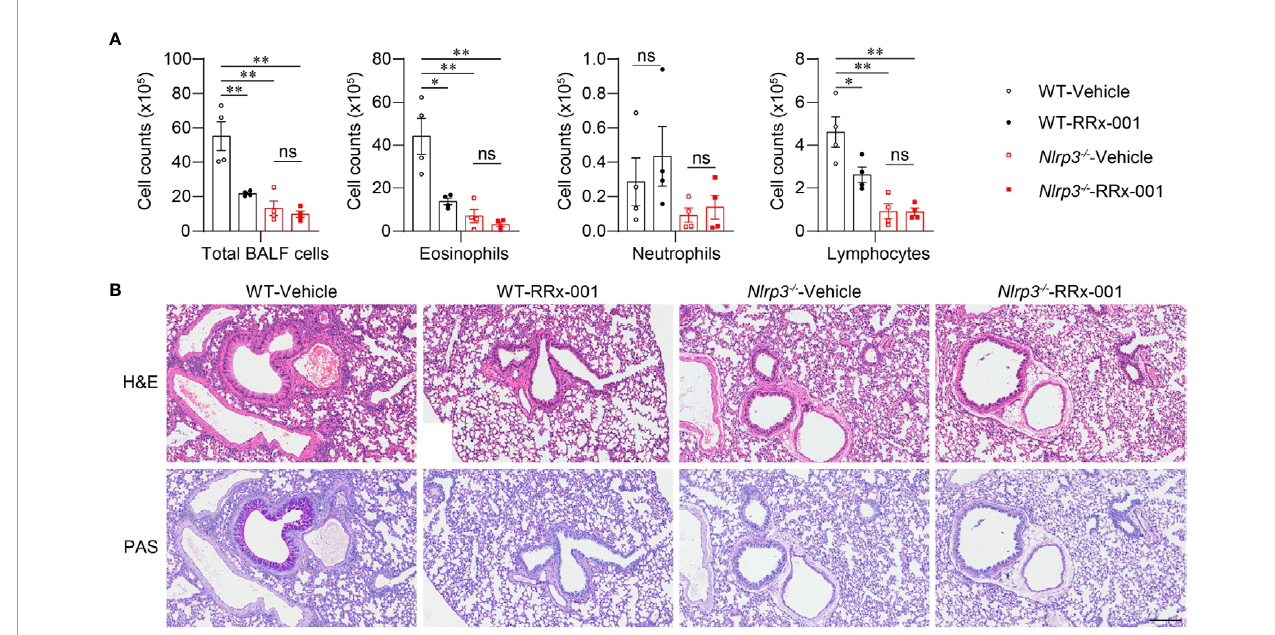
FIGURE 6 | The therapeutic effects of RRx-001 on allergic asthma are dependent on NLRP3. (A, B) WT and Nlrp3 -/- mice were induced allergic asthma with 10 m g HDM i.n. on day 0 and days 7-11, and given 10mg/kg RRx-001 or vehicle i.p. on days 7, 9, and 11. On day 14, all mice were euthanized for analysis. (A) Counts of total BALF cells, eosinophils, neutrophils and lymphocytes; n = 4 biologically independent mice. (B) Histological analysis of lung sections stained with H&E and PAS (Scale bar = 200 m m); n = 3 biologically independent experiments. Statistical signi fi cances were analyzed by unpaired Student ’ s t -test: * P < 0.05, ** P < 0.01, ns (not signi fi